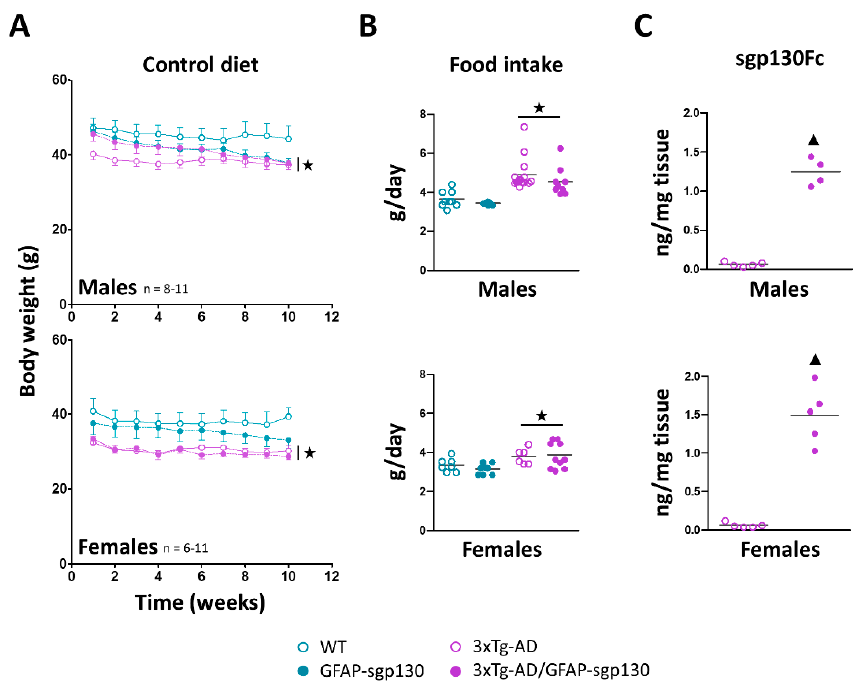
Figure 1. Body weight and food intake alterations in control diet. ( A ) During the control diet phase, 3xTg-AD mice presented lower body weight. The inhibition of the IL-6 trans-signaling did not have a significant effect. ( B ) 3xTg-AD mice presented increased food intake in both sexes, with no effect of the sgp130Fc protein. ( C ) Sgp130Fc quantification by ELISA in brain cortex of AD mice. Results are MEAN ± SEM. ★ p ≤ 0. 05 vs. 3xTg-AD negative ; ▲ p ≤ 0.05 vs. sgp130Fc negative.